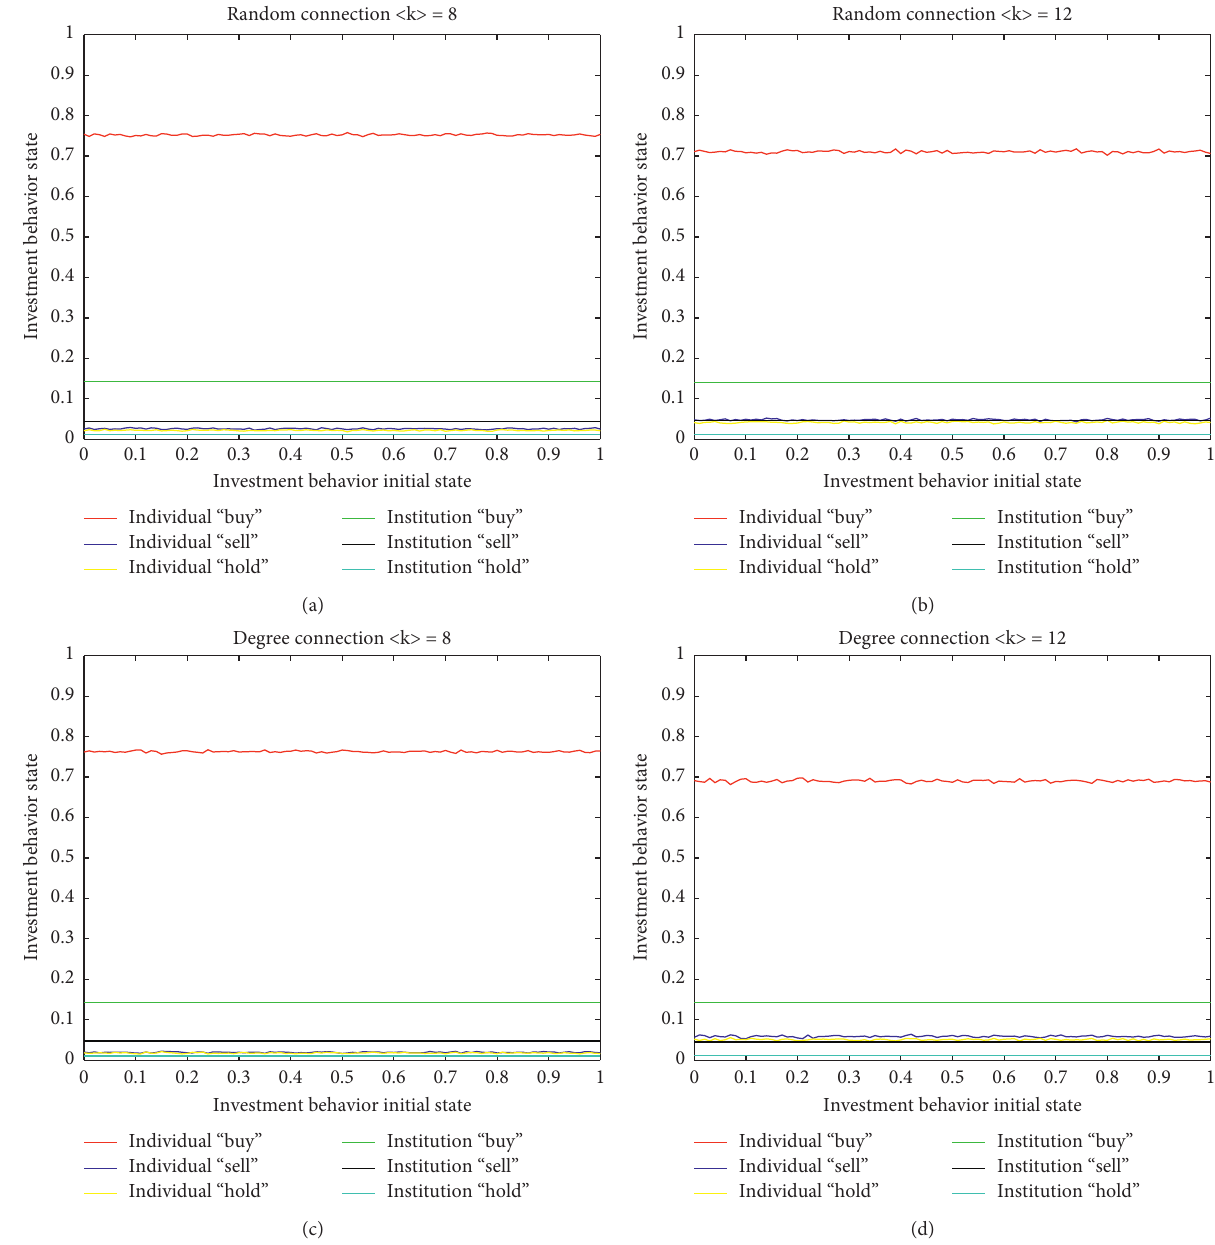
Figure 5: The impact of the initial state on the evolution of investor